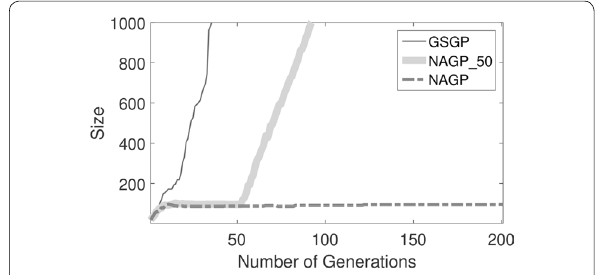
Fig. 8 Evolution of the size of the